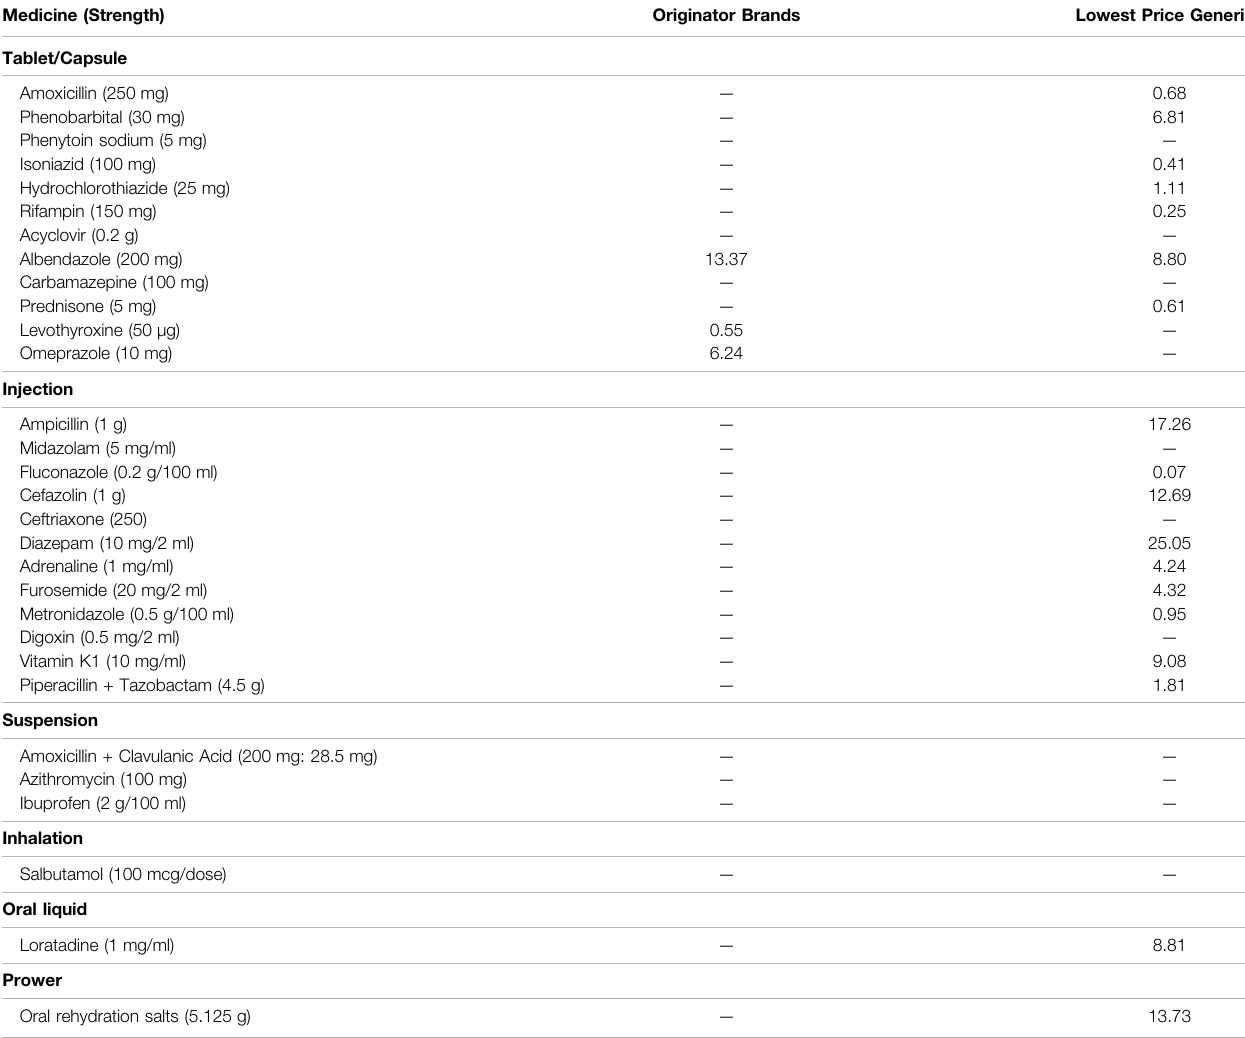
TABLE 5 | MPRs of individual medicines for children. Medicine